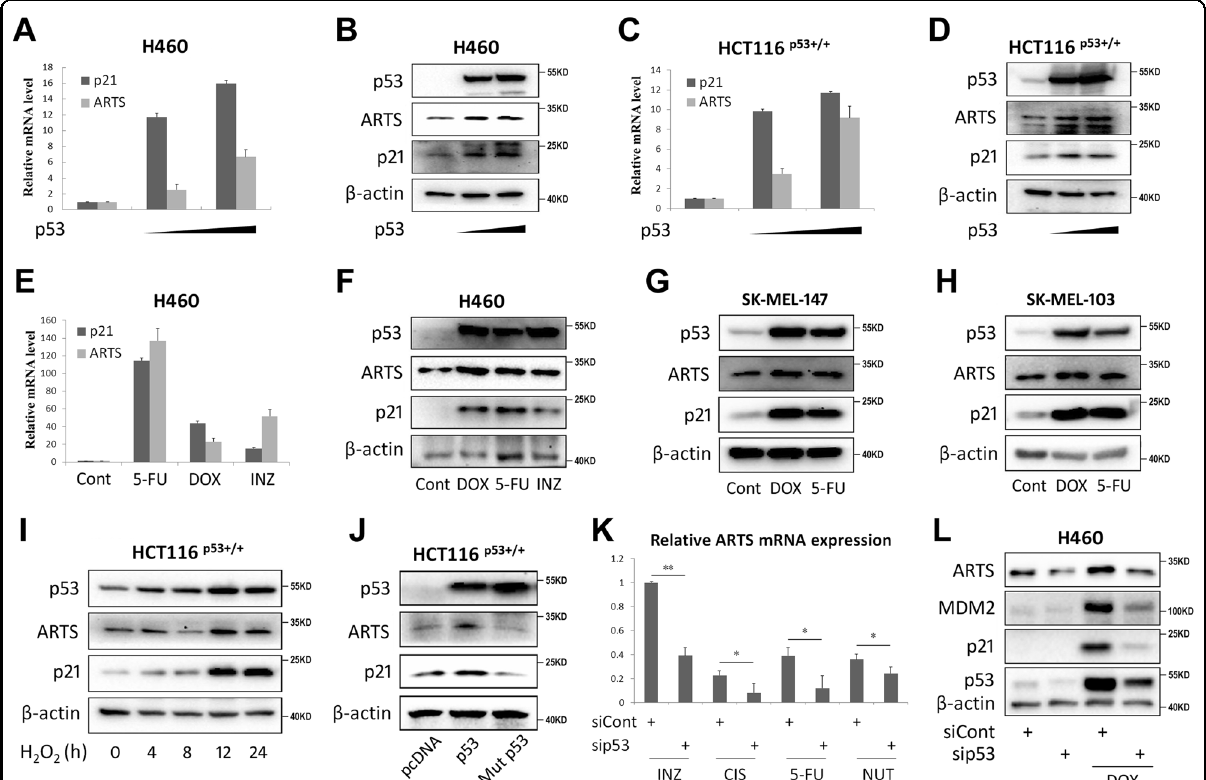
Fig. 1 p53 induces ARTS expression in cancer cells. A , B Ectopic p53 induces ARTS mRNA ( A ) and protein ( B ) expression in H460 cells. Cells were transfected with the vector or increased doses of p53 plasmid followed by RT-qPCR or IB analysis. C , D Ectopic p53 induces ARTS mRNA ( C ) and protein ( D ) expression in HCT116 p53 + / + cells. Cells were transfected with the vector or increased doses of p53 plasmid followed by RT-qPCR or IB analysis. E , F The p53-inducing agents elevate ARTS mRNA ( E ) and protein ( F ) levels in H460 cells. Cells were treated with 5- fl uorouracil (10 μ M), Doxorubicin (1 μ M), or Inauhzin (2 μ M) for 18 h followed by RT-qPCR or IB analysis. G , H The p53-inducing agents elevate ARTS expression in melanoma cell lines. Cells were treated with 5- fl uorouracil (10 μ M) or Doxorubicin (1 μ M) for 18 h followed by IB analysis. I H 2 O 2 -induced oxidative stress increases ARTS expression. Cells were treated with H 2 O 2 for the indicated time followed by IB analysis. J Wild-type p53, but not mutant